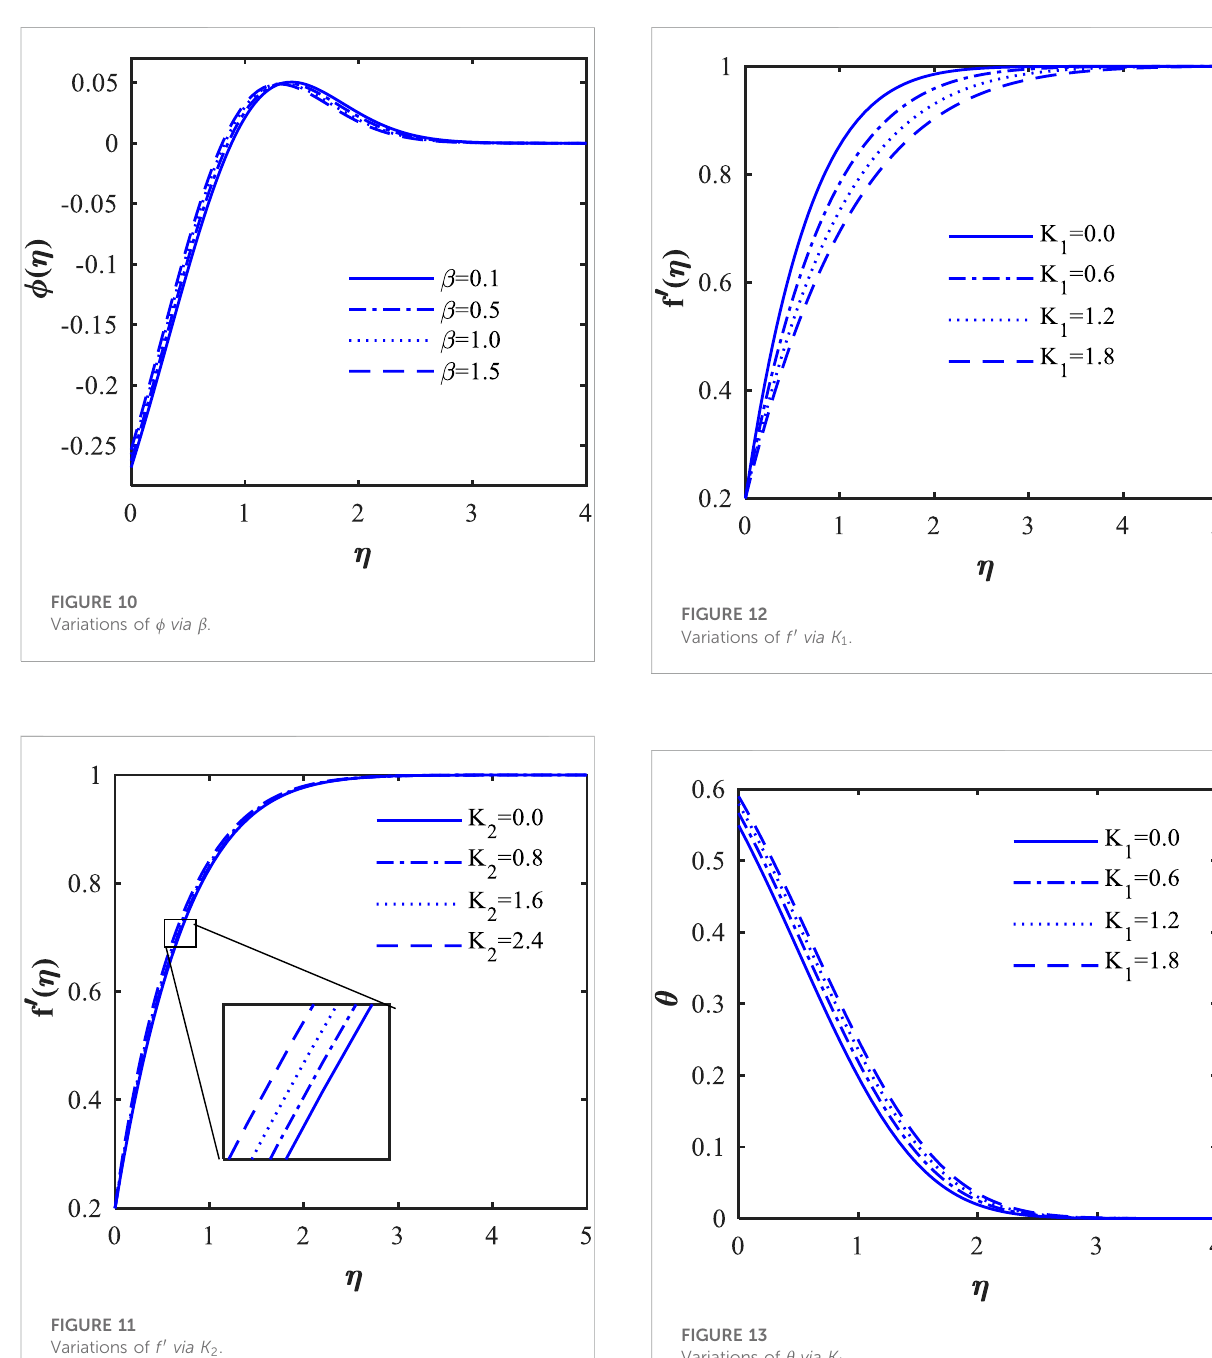
FIGURE 13 Variations of θ via K 1